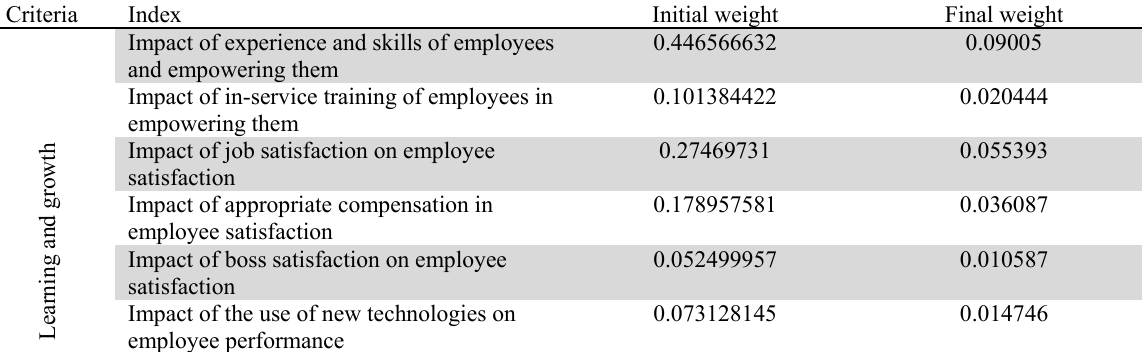
Weights for learning and growth